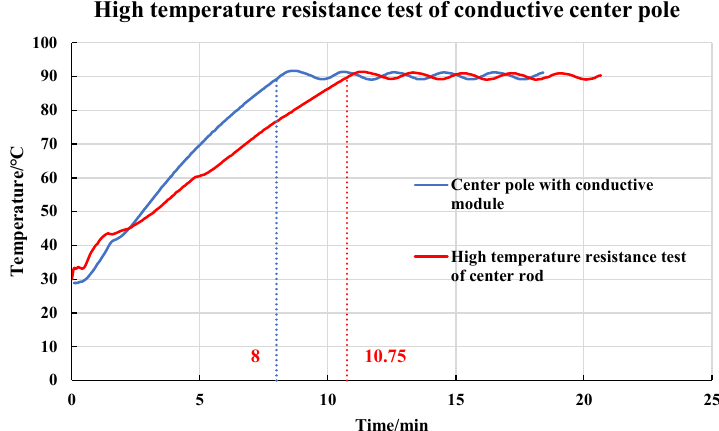
Figure 27. The results of the high-temperature-resistance test of the conductive center pole.